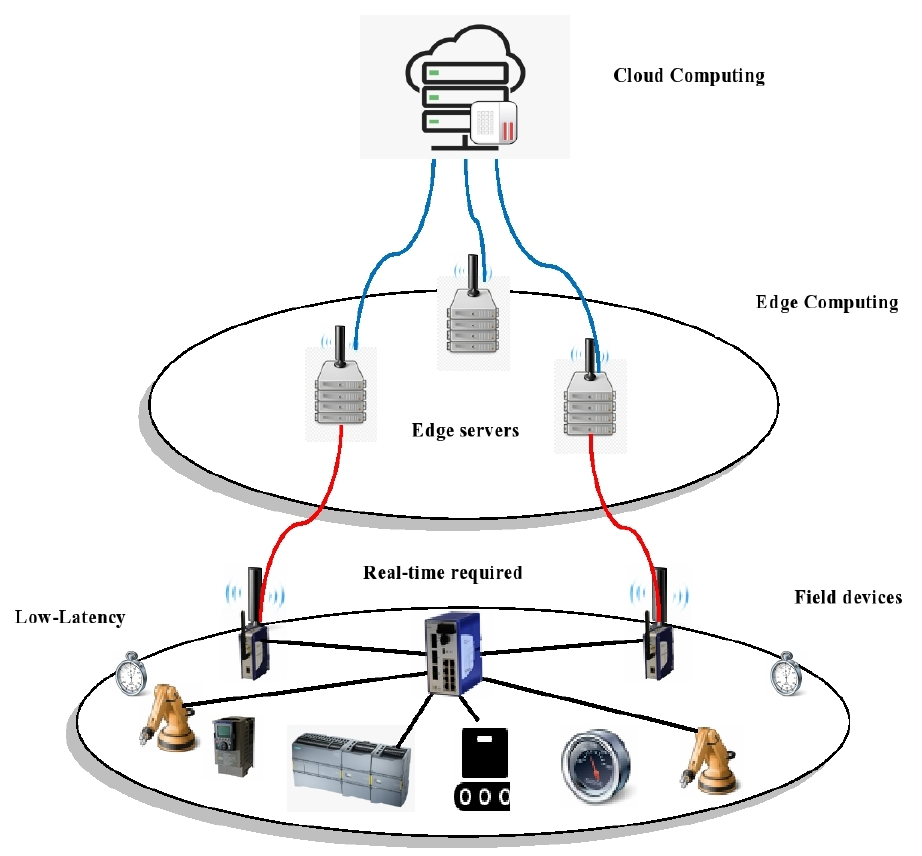
Figure 1. Edge computing